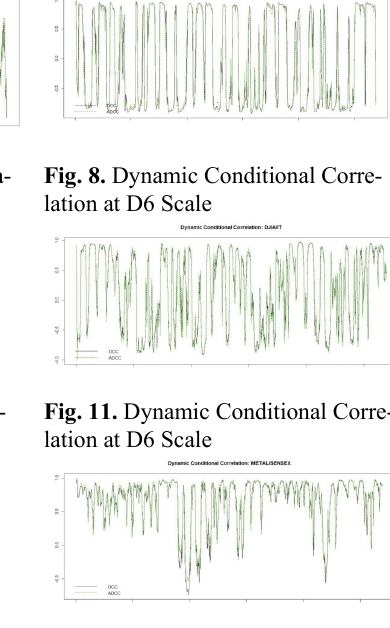
Fig. 14. Dynamic Conditional Corre- lation at D6